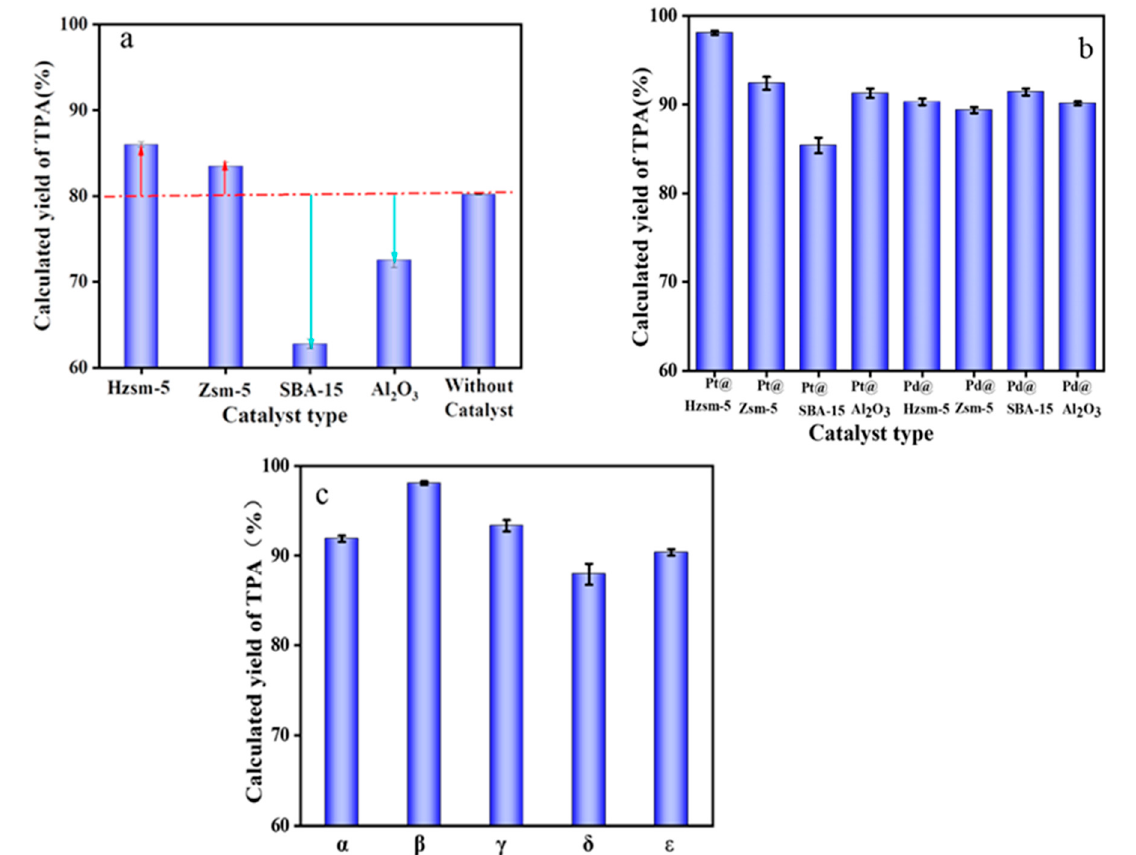
Figure 2. Calculated yields of TPA under di ff erent catalytic conditions (temperature: 400 °C; heating rate: 0.5 °C/min; fl ow rate: 0.1 ml/min): ( a ) catalytic e ff ect of various carriers; (The red arrow means that the yield increases, and the blue arrow means that the yield decreases) ( b ) catalytic e ff ect of Pt and Pd catalysts with di ff erent carriers (metal loading—1 wt%; catalyst to PET feeding ratio—1:10); ( c ) e ff ect of Pt loading and the feeding ratio on the catalytic e ff ect of the Pt@Hzsm-5 ( α Pt loading— 0.5 wt%; feeding ratio—1:10; β , Pt loading—1.0 wt%; feeding ratio—1:10; γ , Pt loading—2.0 wt%; feeding ratio—1:10; δ , Pt loading—1.0 wt%; feeding ratio—1:20; ε , Pt loading—1.0 wt%, feeding ratio—1:5).